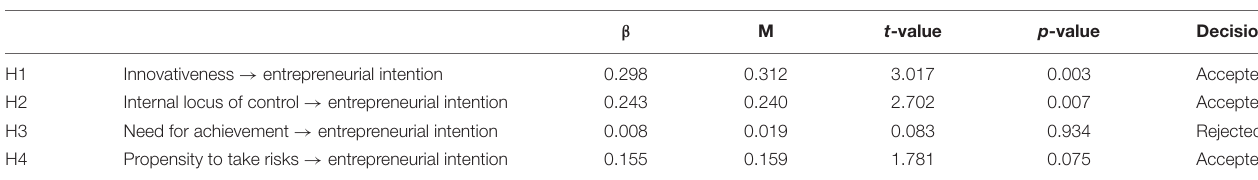
FIGURE 2 | Path coefficients. Source: Primary data. TABLE 8 | Path